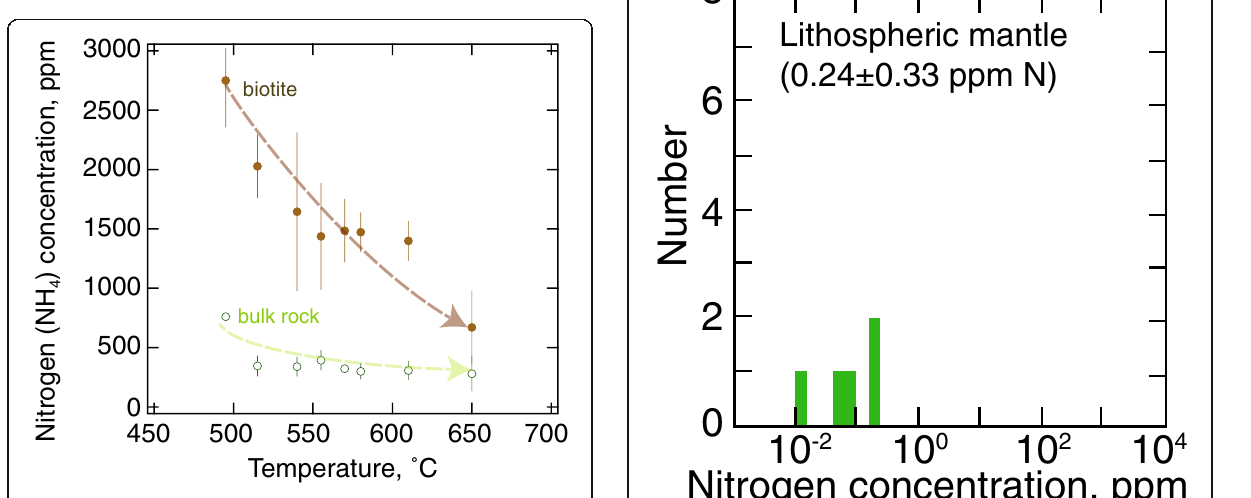
Fig. 4 Nitrogen content of bulk rock and of its biotite in metamorphic rocks from Western Maine (USA) as a function of temperature (metamorphic grade) (data from Plessen et al. 2010)